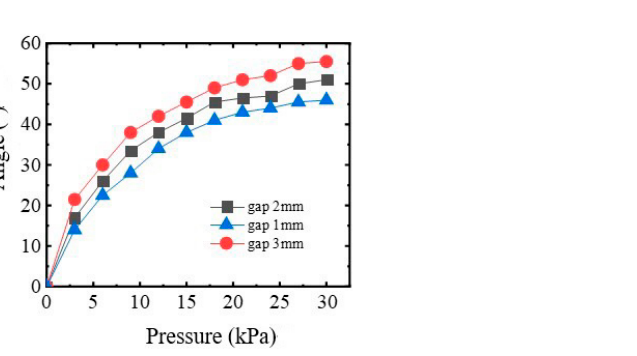
Figure 8. The effect of gap on the performance of rotating actuator for four fingers. The rotating angle under various pressures is shown in Figure 9; it is easy to see that with the increases of pressure applied, the rotating angle keeps increasing. Moreover, it